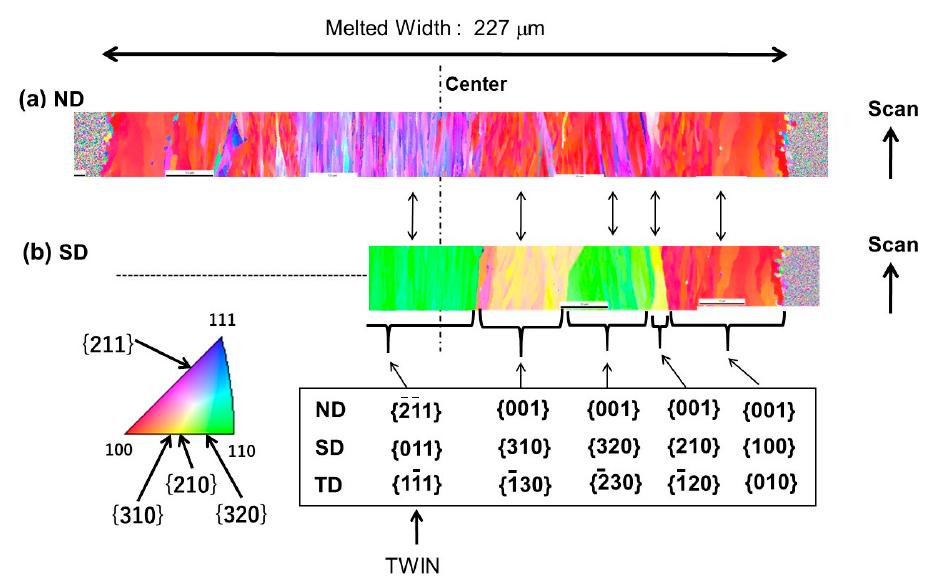
Figure 18. Global textures of the crystallized film at a higher laser power. ( a ) IPF ND map, and ( b ) IPF SD map. The SiO 2 cap thickness was 84 nm, and the power was 1.4 W. The scan velocity was 15 mm/s. After Sasaki et al. [53].